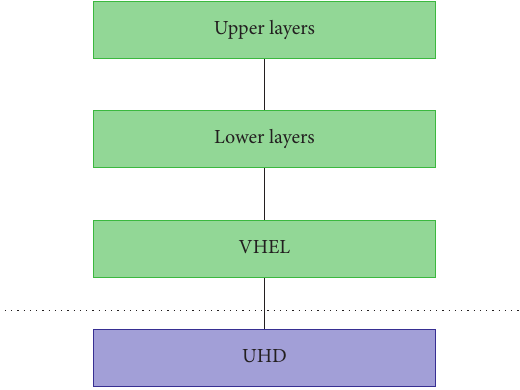
Figure 3: Layers in the ARF